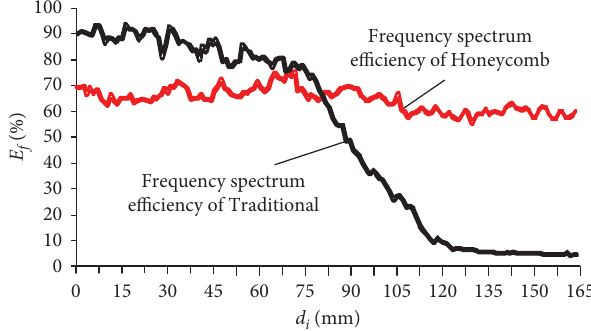
Figure 15: Frequency spectrum efficiency comparison of different vibration networks.